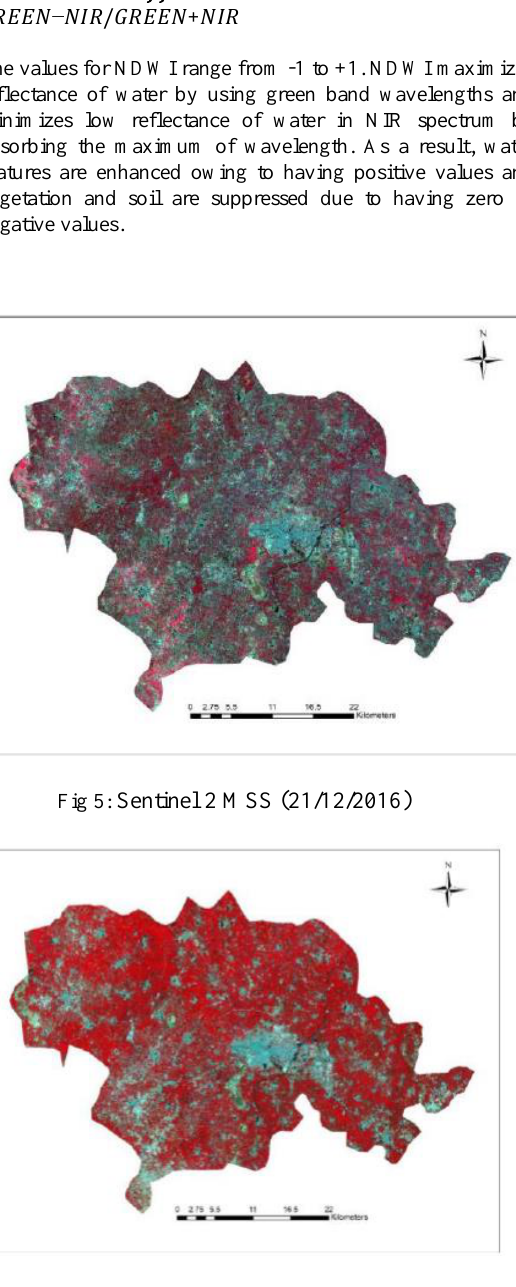
Fig 6: Sentinel 2 MSS